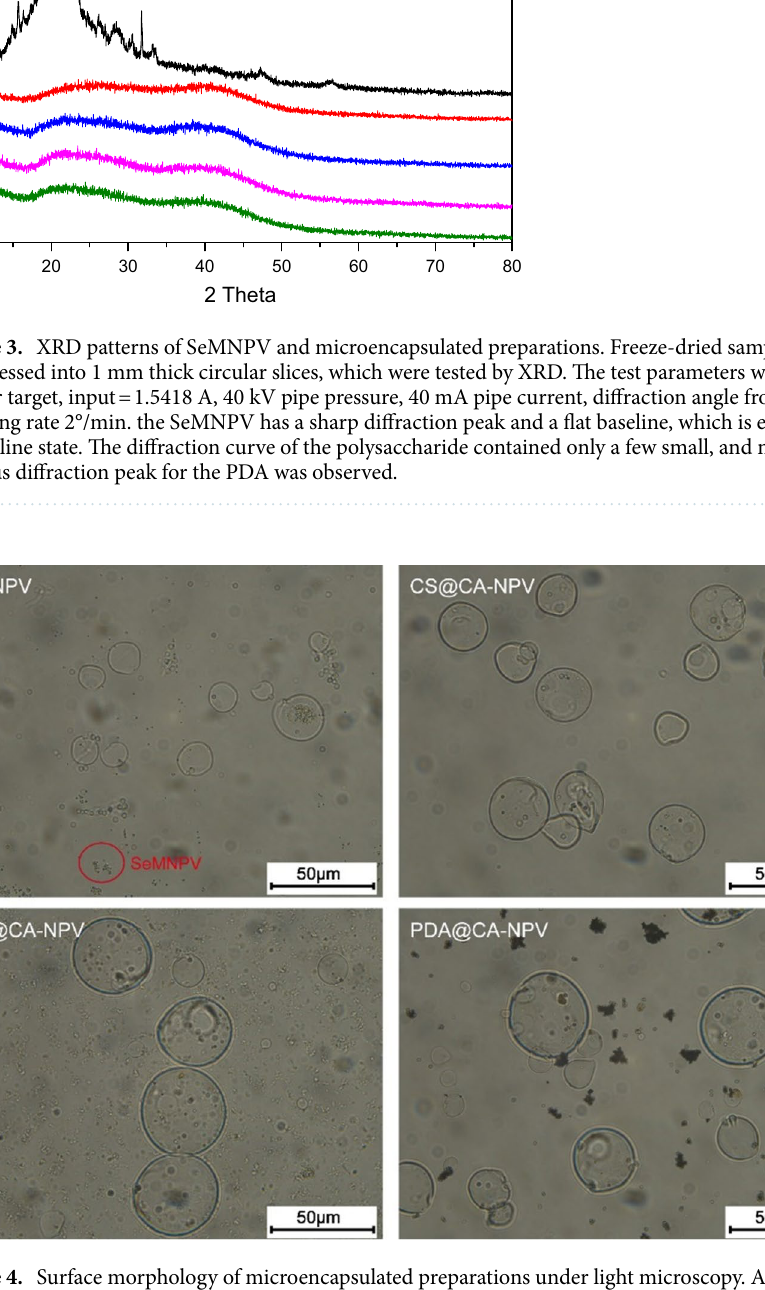
positively charged and self-assembled to form the second shell in CA-NPV. The PDA caused several CA-NPV microcapsules to adhere, forming massive microcapsules. Therefore, the size of PDA@CA-NPV microcapsules was larger than that of electrostatic self-assembled microcapsules.